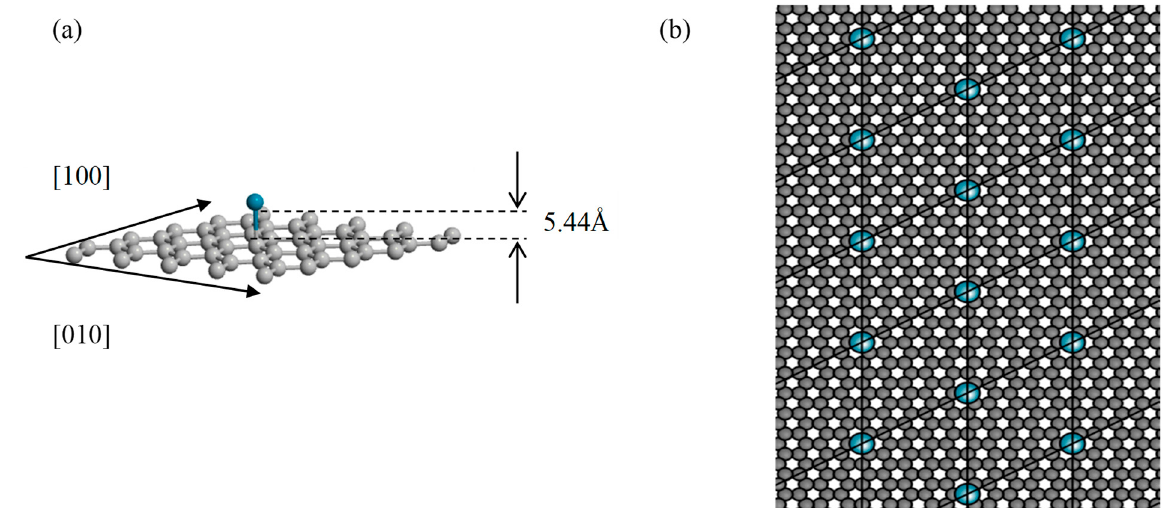
Figure 3. ( a ) The Pd-decorated graphene structure with C—Pd bond length; ( b ) extended surface of Pd decorated graphene considered for the energy band structure calculations.